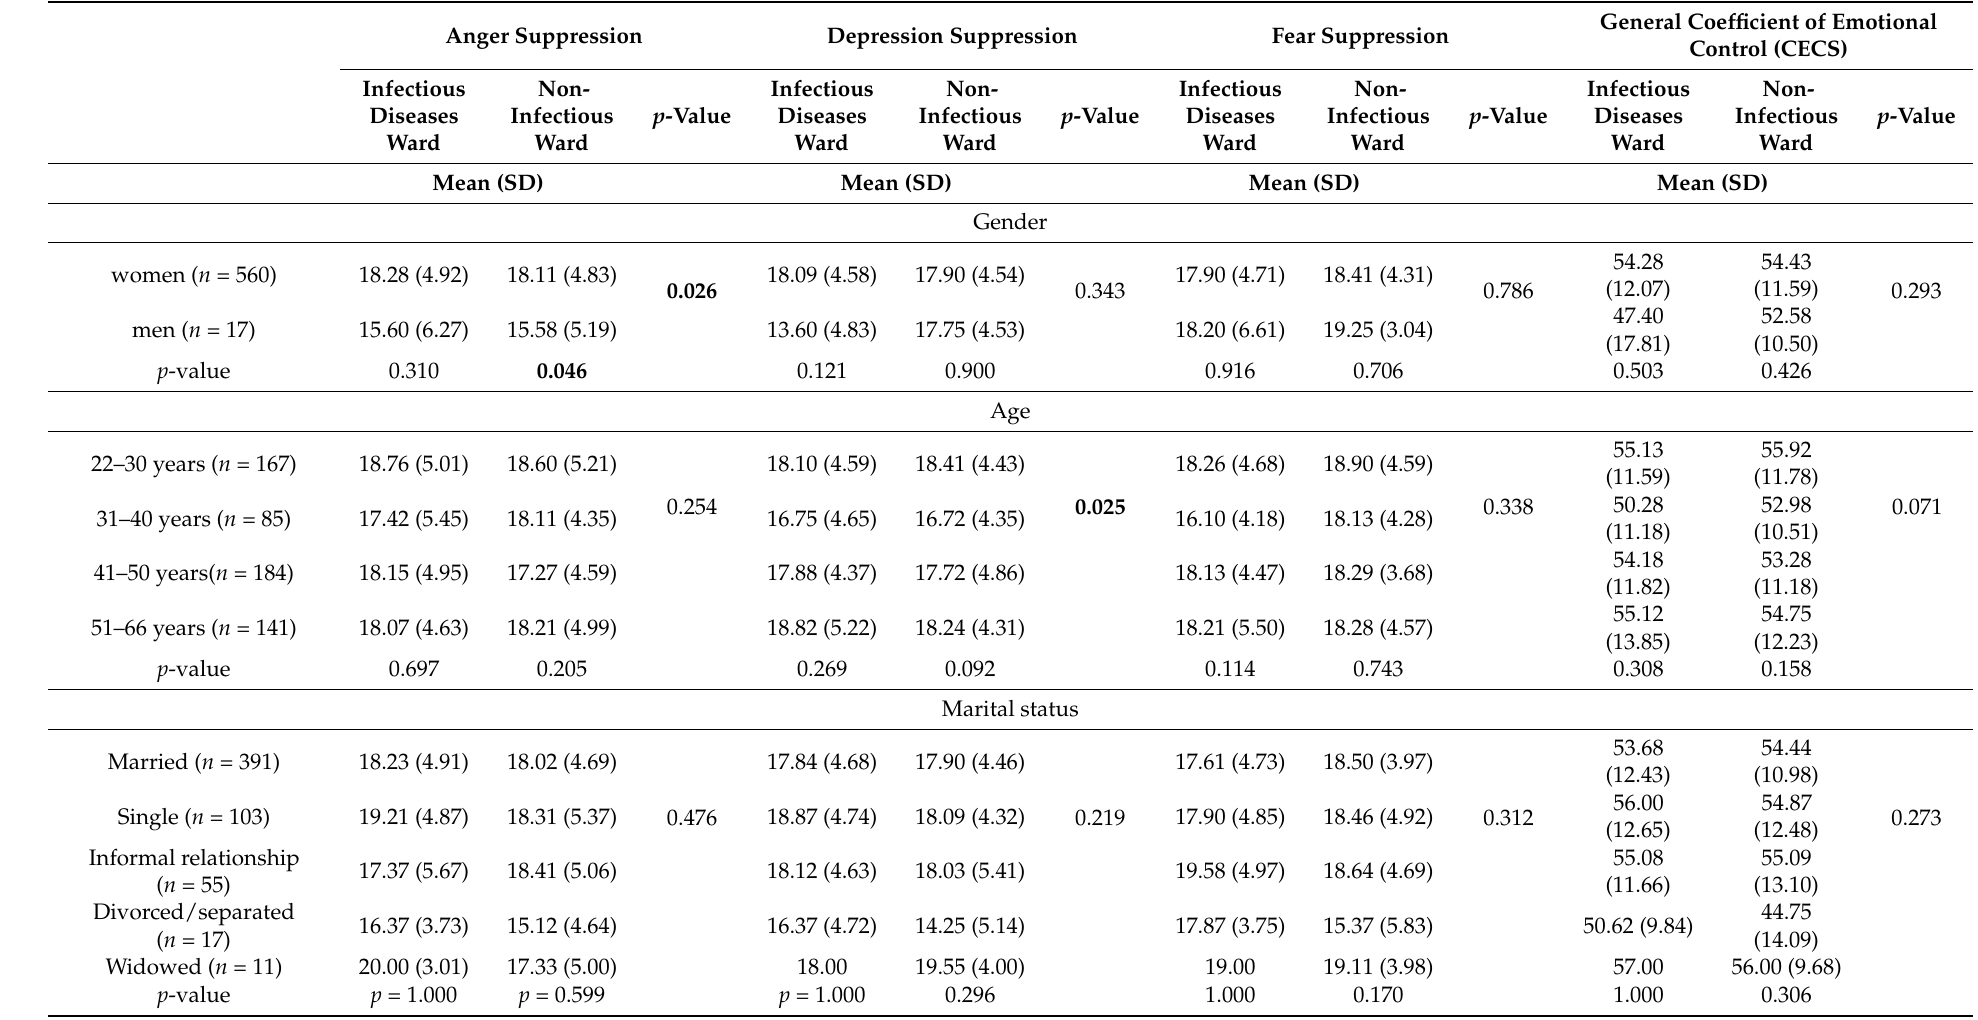
Table 2. Controlling emotions of the surveyed nurses depending on sociodemographic data. General Coefficient of Emotional Anger Suppression Depression Suppression Fear Suppression Control (CECS) Infectious Non- Infectious Non- Infectious Non- Infectious Non- p -Value p -Value p -Value Diseases Infectious Diseases Infectious Diseases Infectious Diseases Infectious Ward Ward Ward Ward Ward Ward Ward